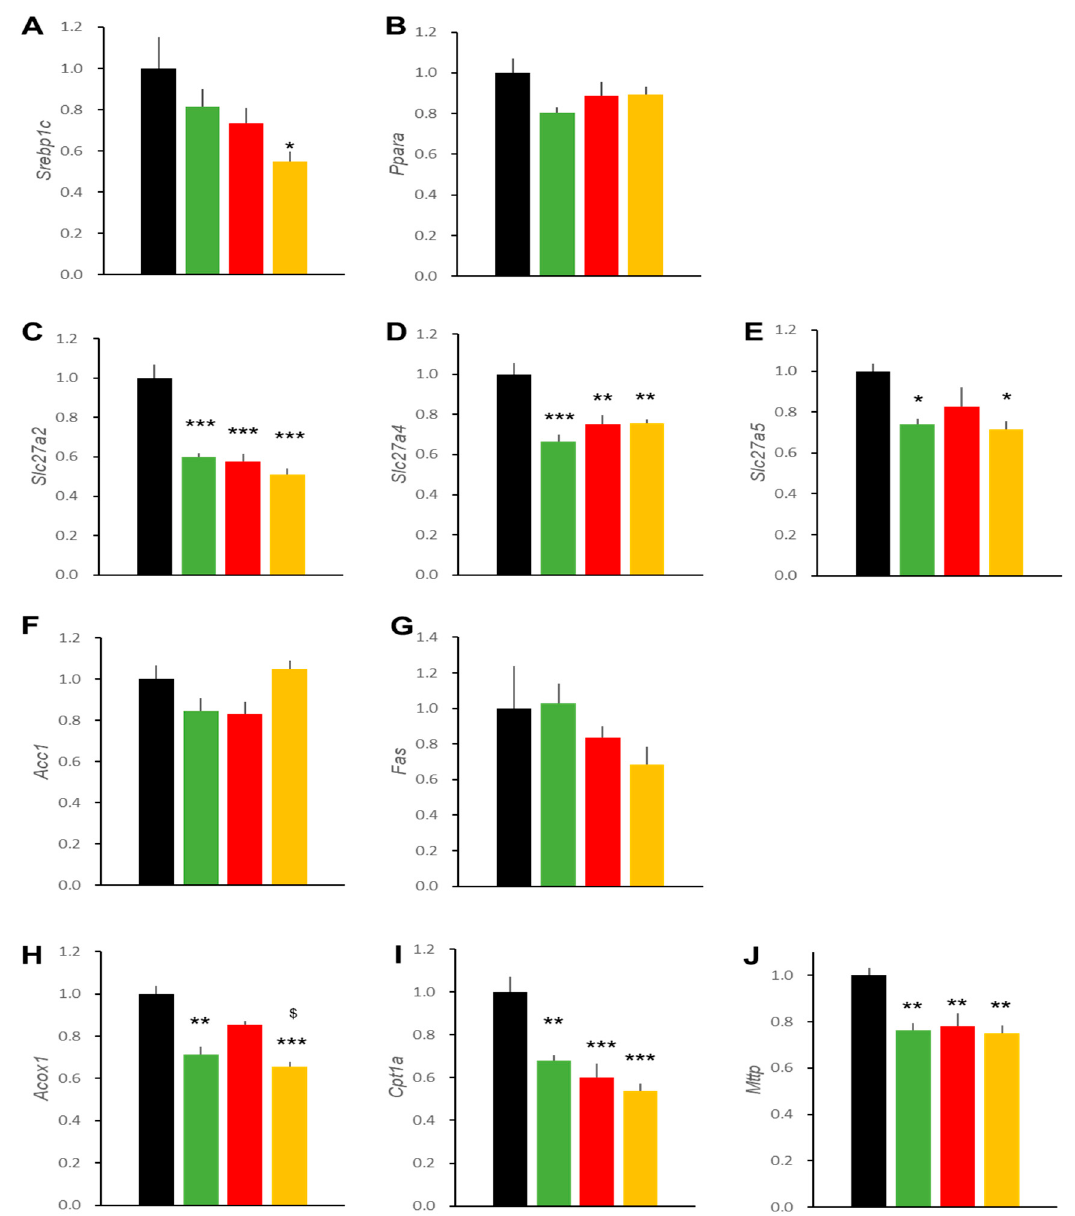
Figure 10. Effects of treatments on hepatic expressions of genes related to lipid metabolism in db/db mice. Expression of two master regulator genes of hepatic lipid metabolism: Srebp1c ( A ) and Ppara ( B ). Genes important for fatty acid uptake: Fatp2 ( C ), Fatp4 ( D ), and Fatp5 ( E ). Genes important for fatty acid synthesis: Acc1 ( F ) and Fas ( G ), and for fatty acid oxidation: Acox1 ( H ) and Cpt1a ( I ). Gene important for TG excretion: Mttp ( J ). Data represent mean ± SE, n = 6, * p < 0.05, ** p < 0.01, and *** p < 0.001 vs. control group. $ p < 0.05 vs. IPRA group.